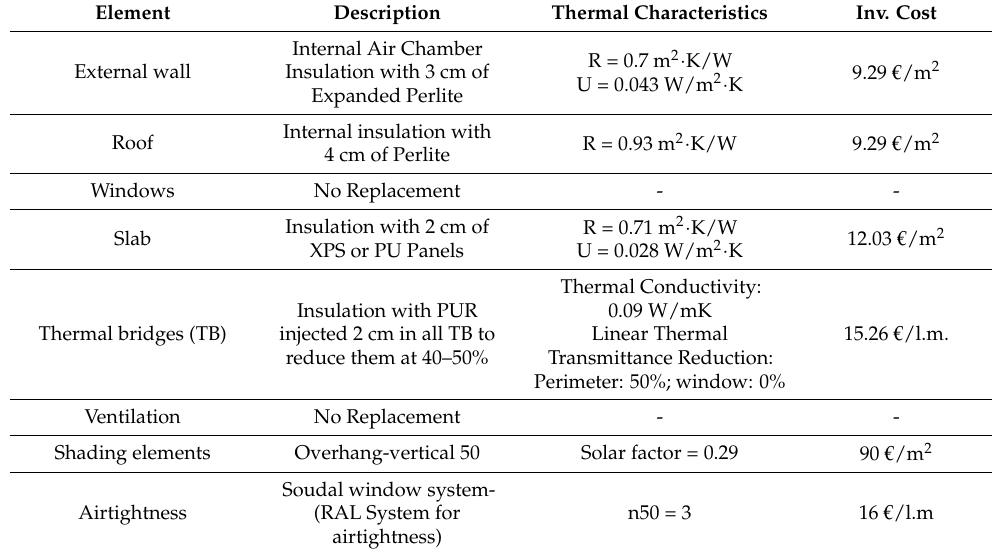
Table A9. POS10s: Renovation measures of solution 2.